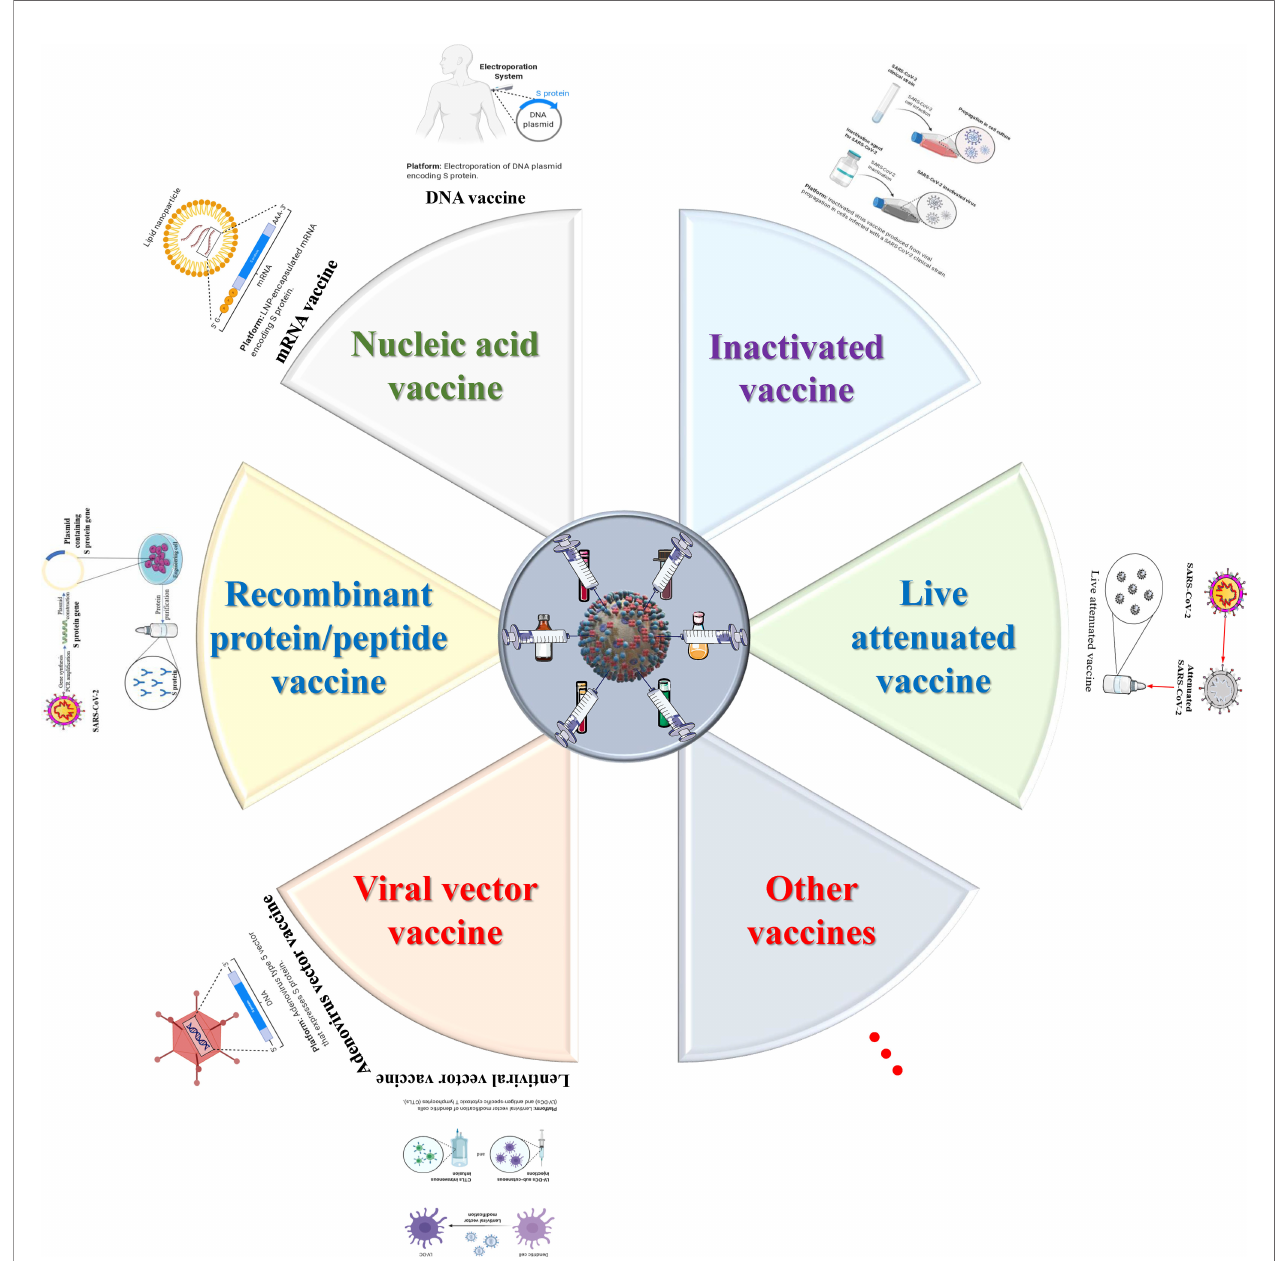
FIGURE 5 | The design and development model of SARS-CoV-2/COVID-19 vaccines. One of the most important intervention strategies for COVID-19 is vaccine control. To date, six major types of vaccine candidates (live attenuated vaccines, recombinant protein/peptide vaccines, inactivated vaccines, viral vector vaccines, nucleic acid vaccines and other types of vaccines) are under development, clinical trials, authorized emergency use, and routine preventive use. These six types of candidate vaccines represent the direction of SARS-CoV-2 and even the entire coronavirus vaccine